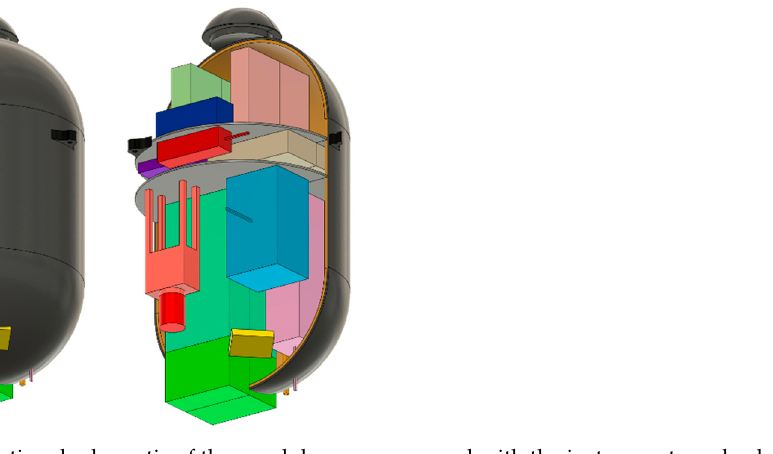
Figure 9. A notional schematic of the gondola pressure vessel with the instruments and subsystems placed on shelves inside the vessel. placed on shelves inside the vessel.